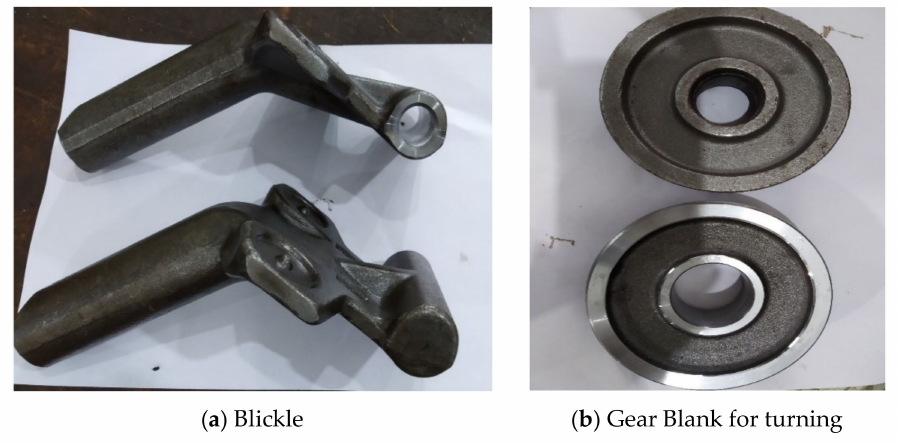
Figure 2. Identified components under study. Table 1. Details of the